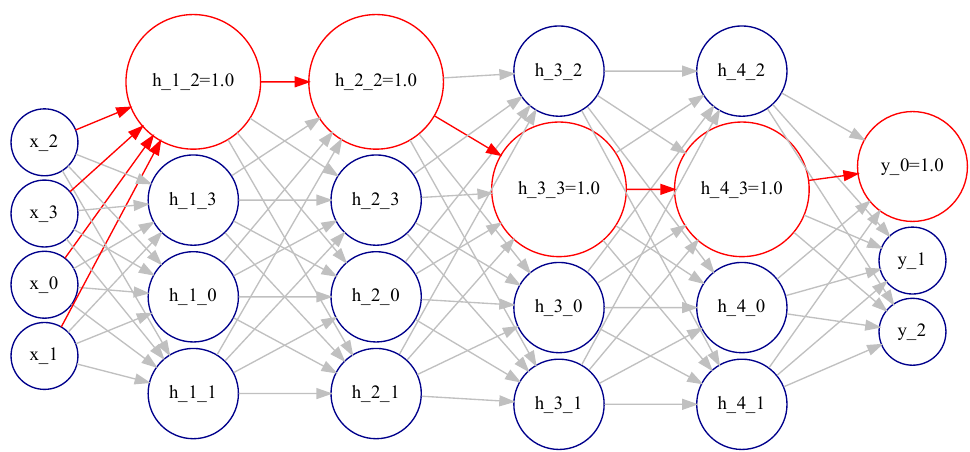
Figure 4. The activation pattern (the most frequently activated neurons) for class 0 is highlighted in red over the DL predictor architecture (Iris dataset). In addition, the most frequent activation values are shown for neurons in the activation